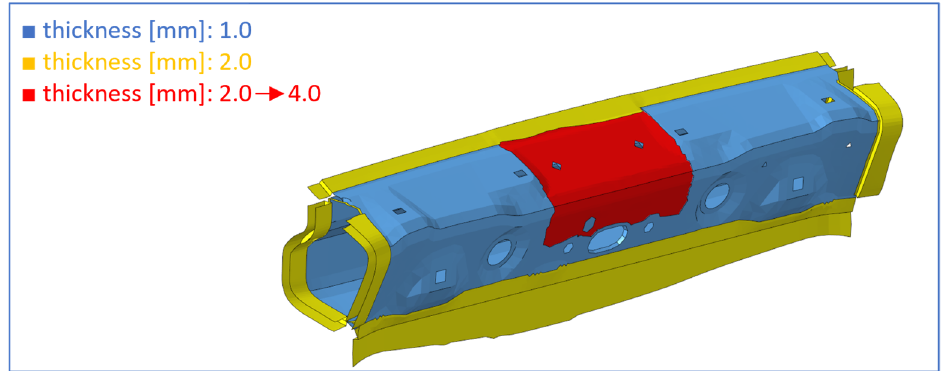
Figure 25. Lock attachment, with increased thickness from 2 to 4 mm in the area highlighted in red.